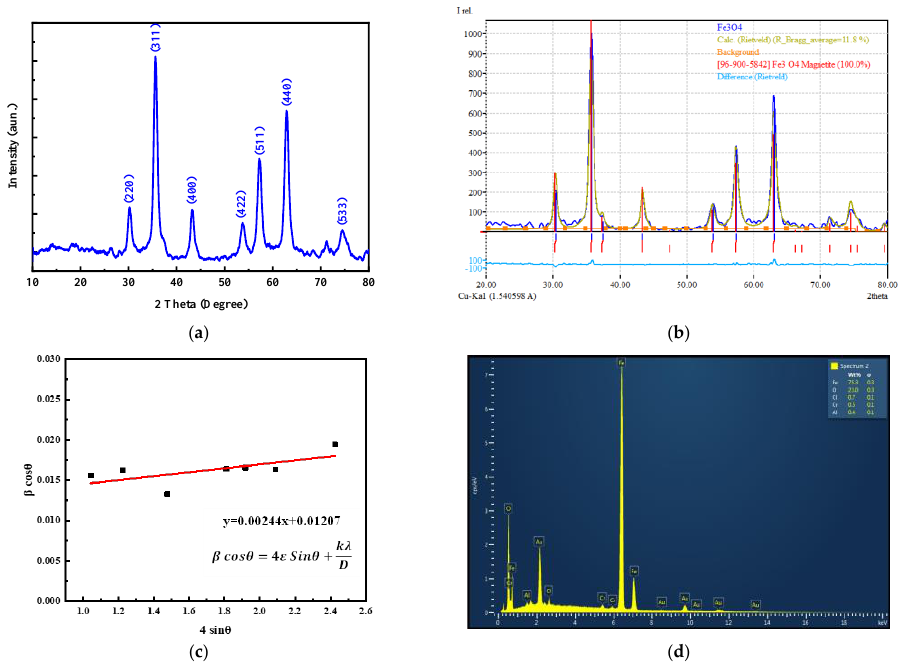
Figure 3. ( a ) XRD patterns; ( b ) Rietveld analysis; ( c ) Williamson–Hall method; and ( d ) EDX spectrum of the synthesized Fe 3 O 4 MNPs. This corroborates well with the TEM and HR-TEM results that clearly show the ex- cellent crystalline lattices of the as-synthesized MNPs and indicate that each particle is a